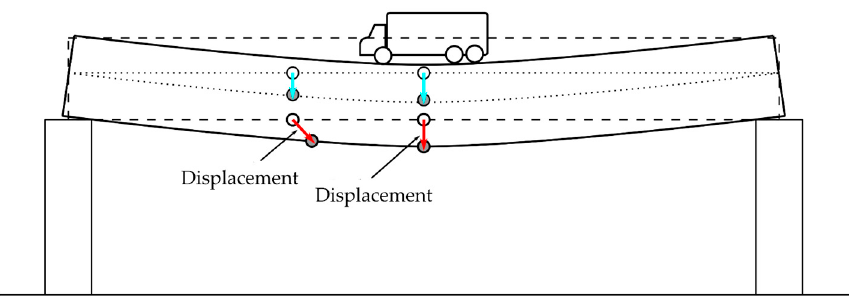
Figure 1. The blue arrows are the displacements of the points of the neutral axis (the dotted lines in the figure) of the bridge; the red arrows are the displacements of the points far from the neutral axis (the figure and the displacements are not to scale).